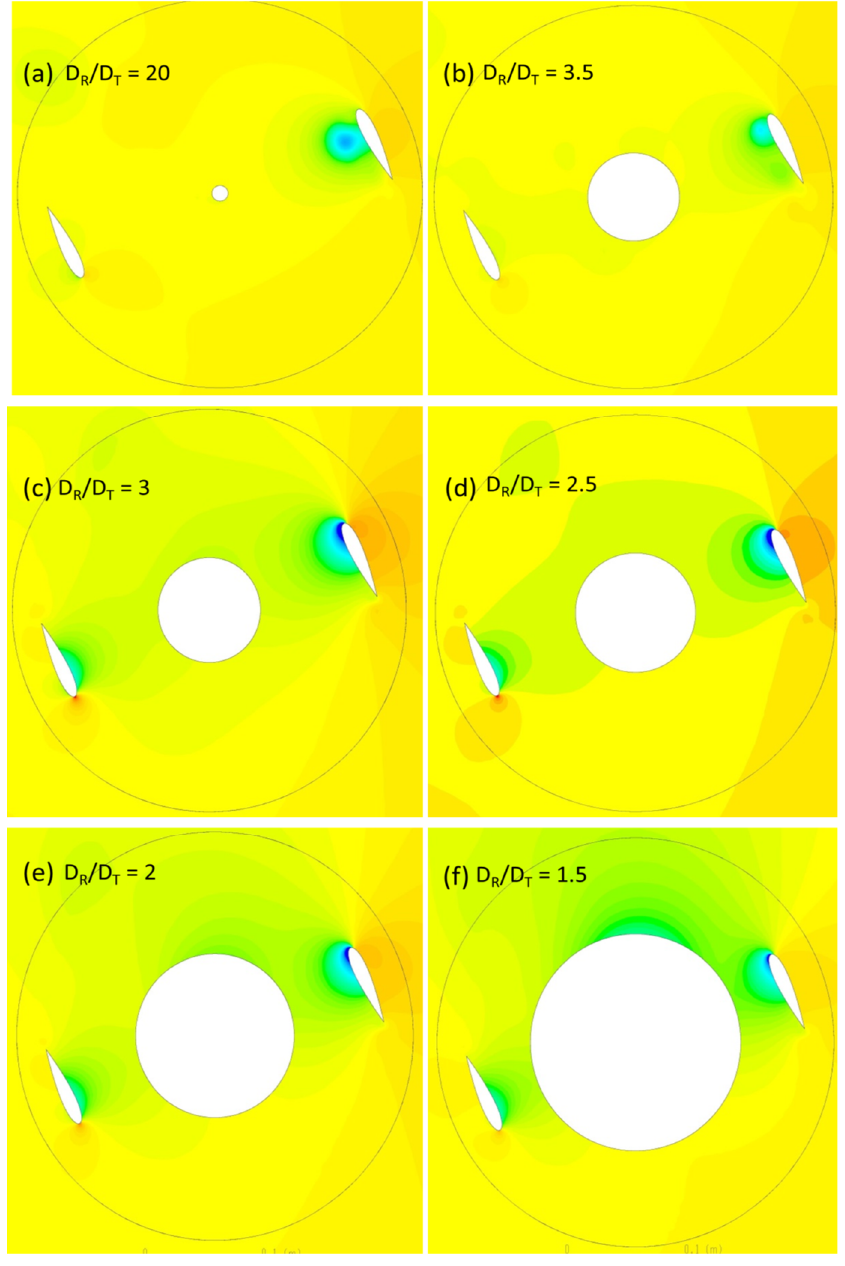
Figure 11. Pressure contours (Pa) for AHDT at β = 30°.